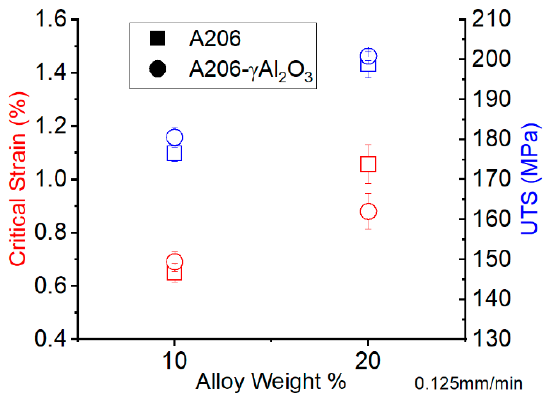
Figure 2. Measured critical strain and UTS at 0.125 mm/min strain rate.